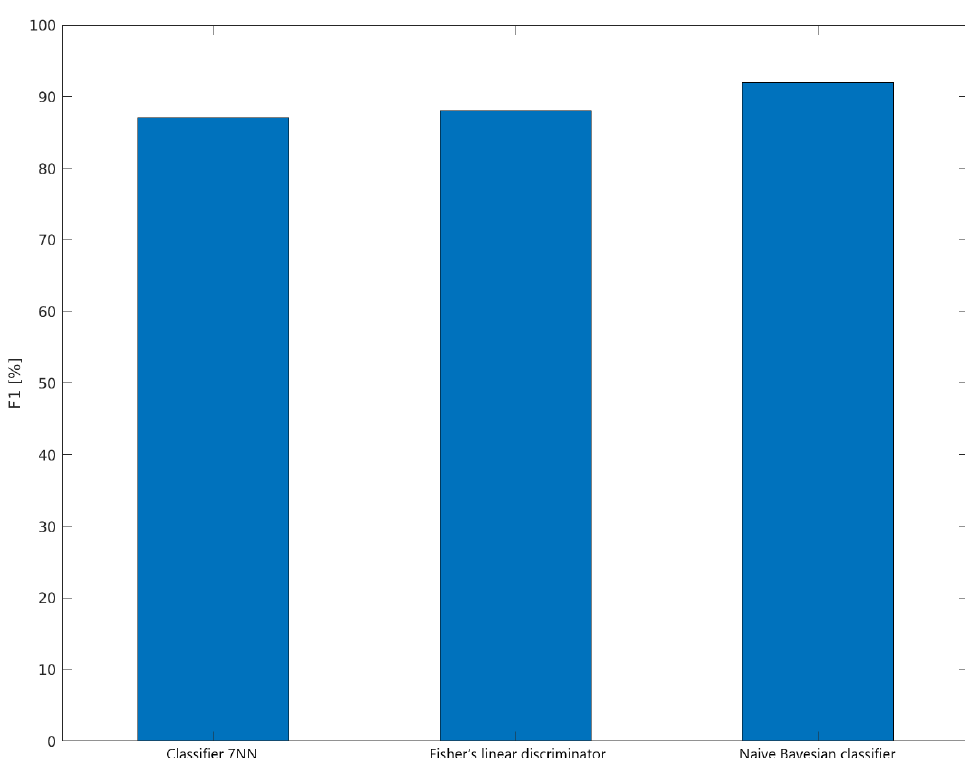
Figure 14. Value of the F1 metric for each of the